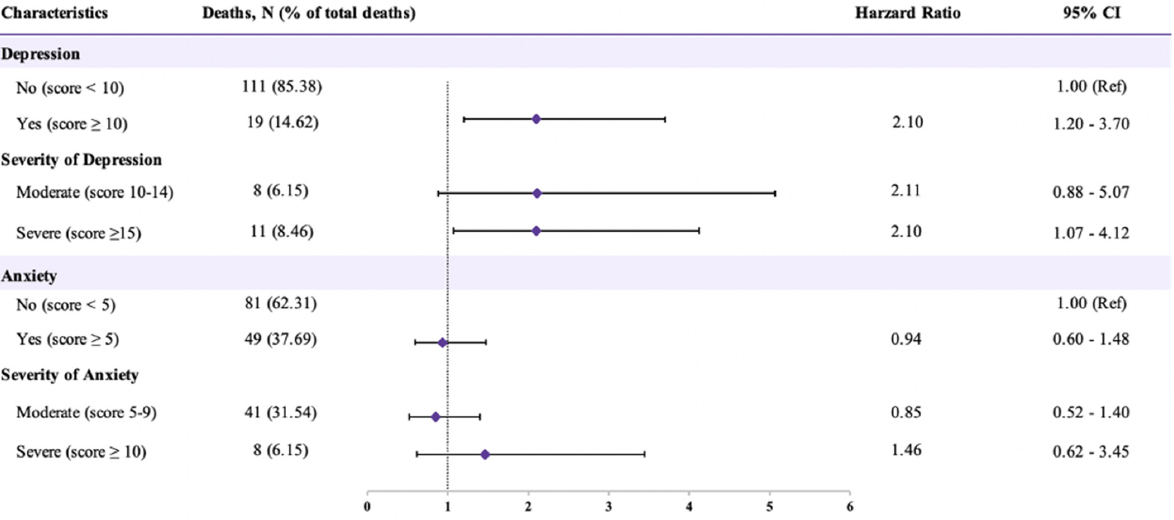
Figure 2. Adjusted hazard ratio and 95% confidence intervals for the association between depression and anxiety symptoms and total mortality among 598 ovarian cancer patients. CI, confidence interval, Ref, reference. Depression symptom was evaluated according to Patient Health Questionnaire-9. Anxiety symptom was evaluated according to Generalized Anxiety Disorder-7.